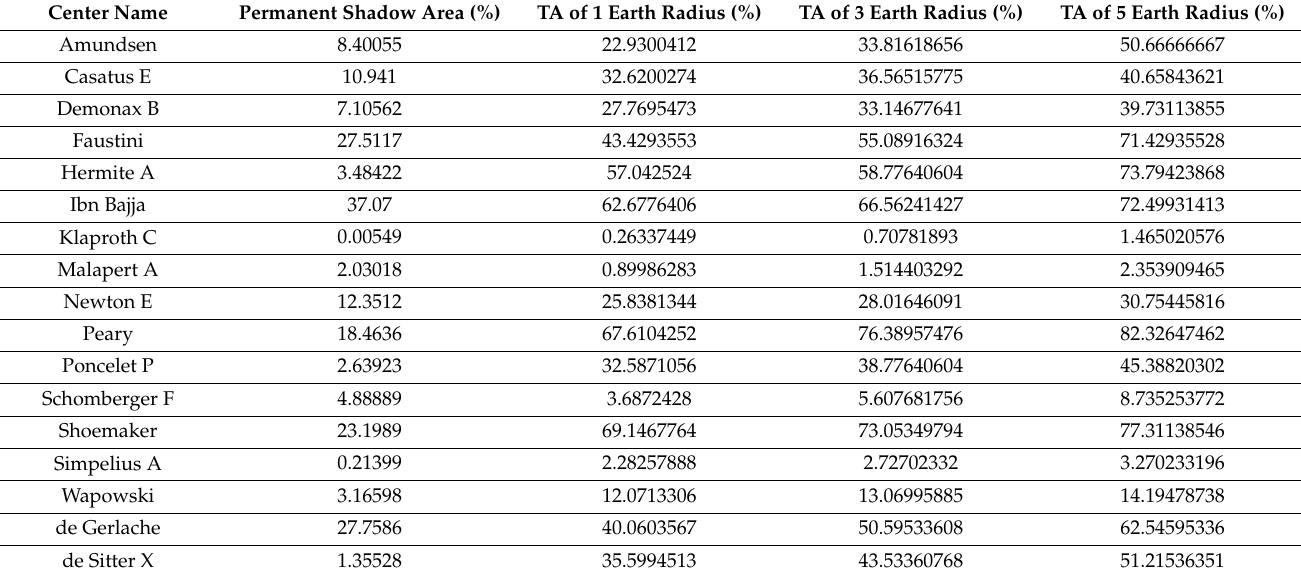
Table 3. Ratios of permanent shadow area and obscured FOV about TA of 1, 3, 5 Earth radius for areas centered in craters.